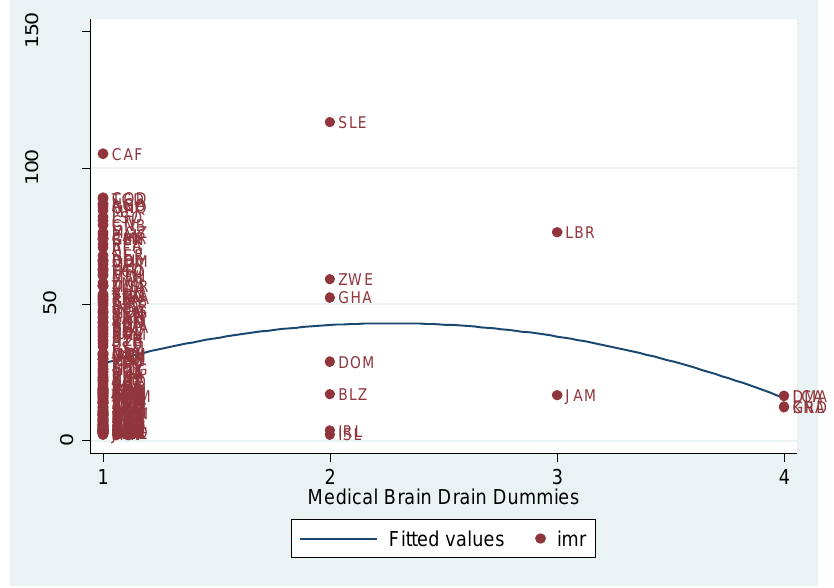
Figure 2. Distribution of infant mortality by the levels of MBD in 188 countries in 2008.